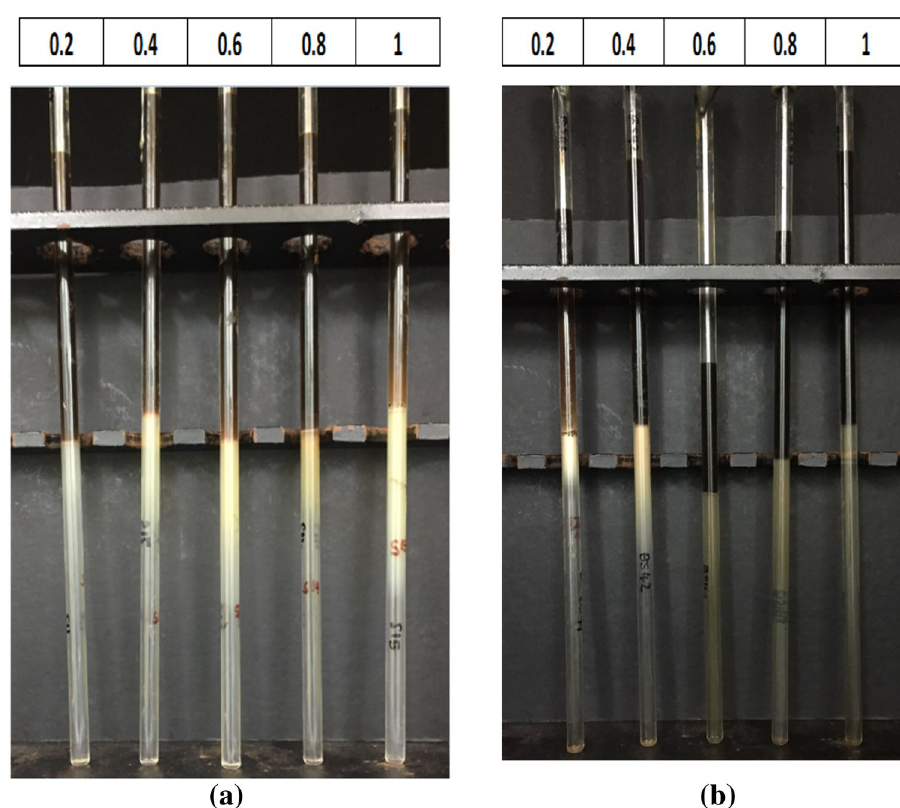
Fig. 12 Phase behavior of formulations of a AEC sur- factant only and b AEC with APG at ratio 50:50 at 106 °C at seawater brine. Total surfactant concentration increases from left to right from 0.2 wt% to 1.0